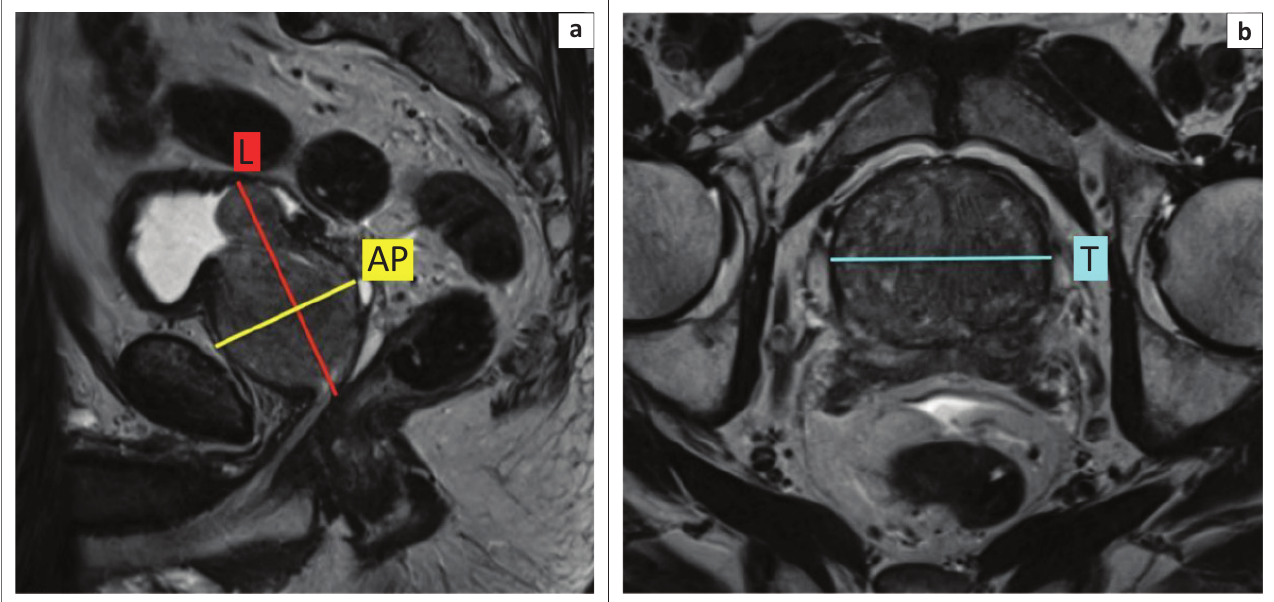
FIGURE 3: Recommended measurements for calculation of prostate volume at magnetic resonance imaging. Maximum longitudinal (L) diameter and maximum antero- posterior (AP) diameter measured on mid-sagittal T2-weighted imaging (T2WI) (a) and maximum transverse (T) diameter measured on axial T2WI